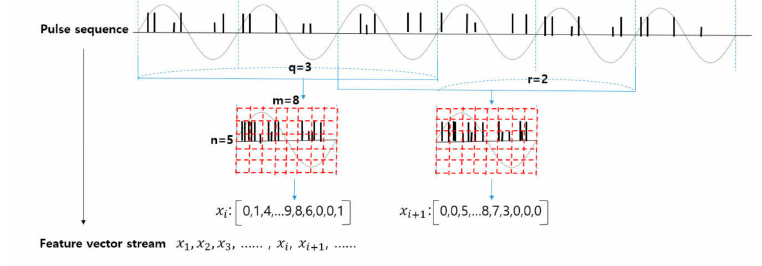
Figure 2. An illustration of the process to convert pulse sequence to a feature vector